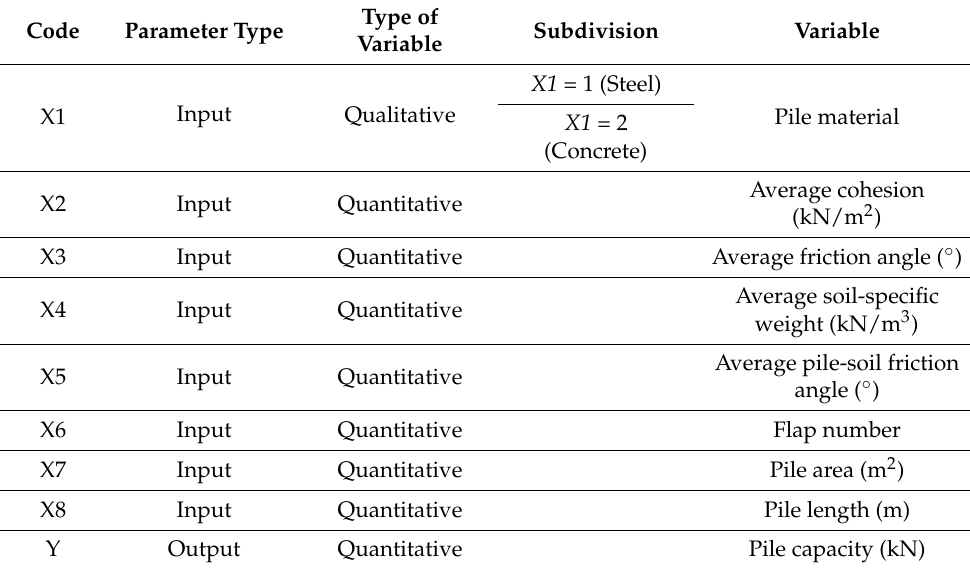
Table 2. Input and output parameters of the proposed